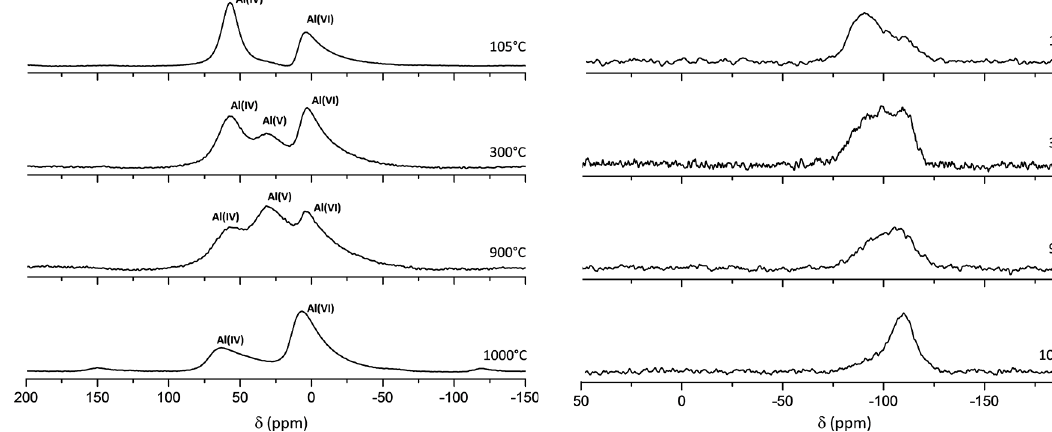
Figure 5. 27 Al NMR spectra of the synthetic aluminosilicate heat treated at 100 °C, 300 °C, 900 °C and 1000 °C.